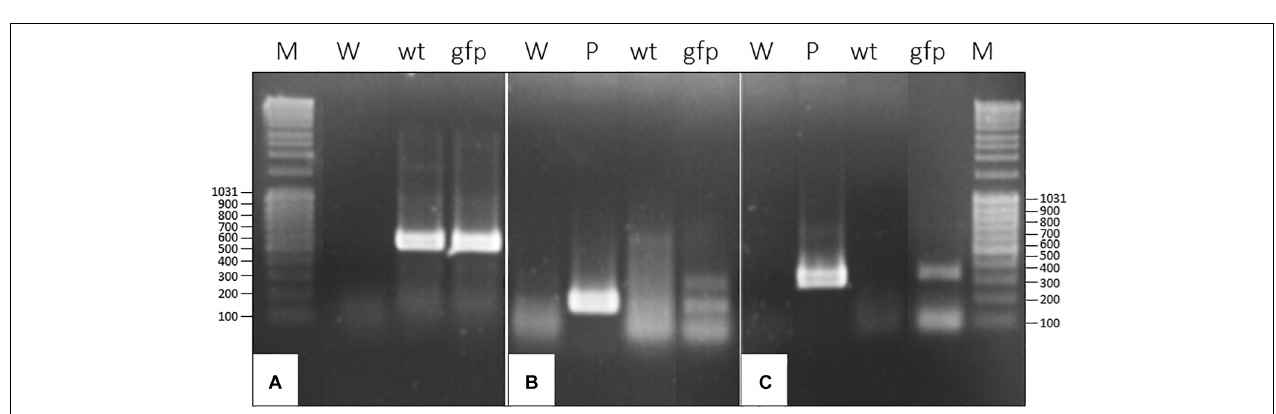
FIGURE 1 | Molecular characterization of gfp -transformed D. capensis from T1 generation produced by chimeric transgenic plants. (A) PCR with primers specific to 18S gene as housekeeping gene (270 bp); (B) PCR with primers specific to gfp gene (720 bp); M, Marker; W, water as negative control; wt, wild-type; P, plasmid harboring the gene as a positive control; 1–12, non-chimeric plants issues from T1 generation.